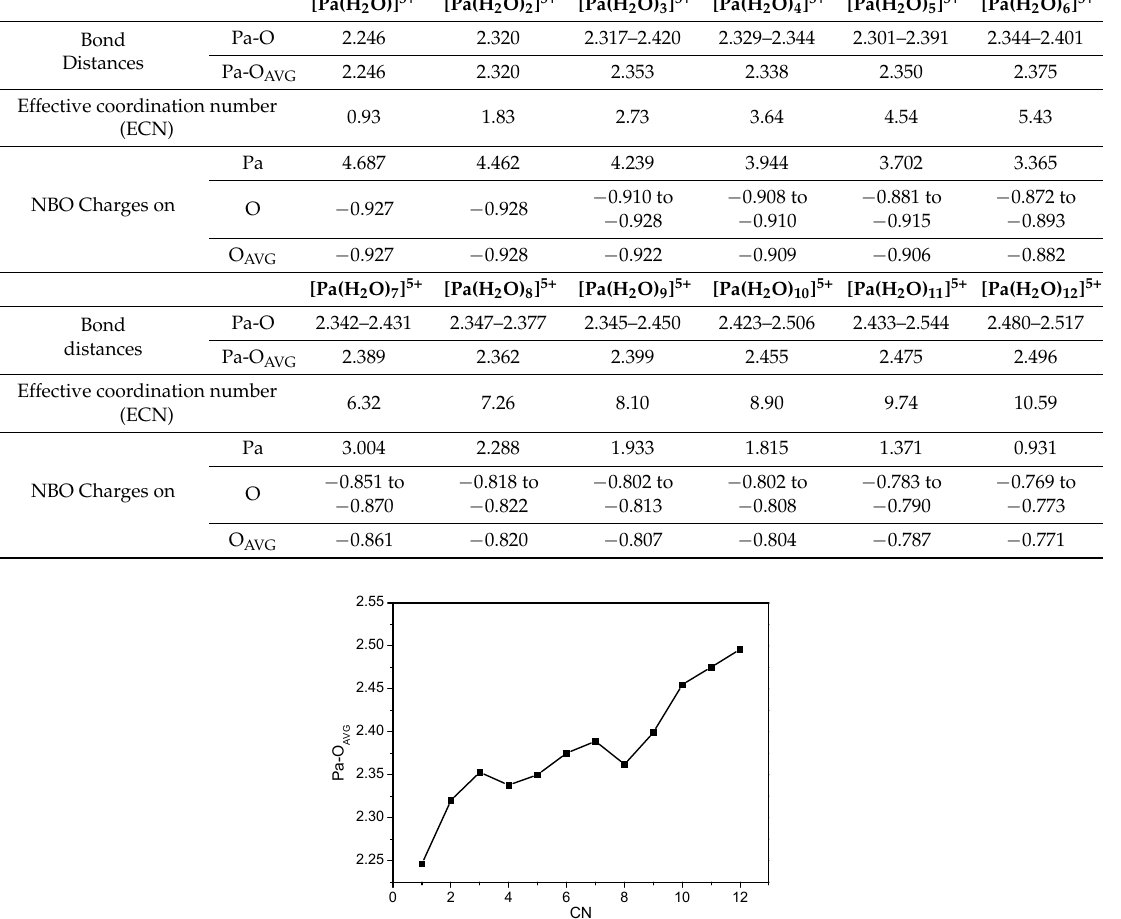
Table 1. The Pa-O, Pa-O AVG distances (in Å), effective coordination numbers (ECN) and natural bond